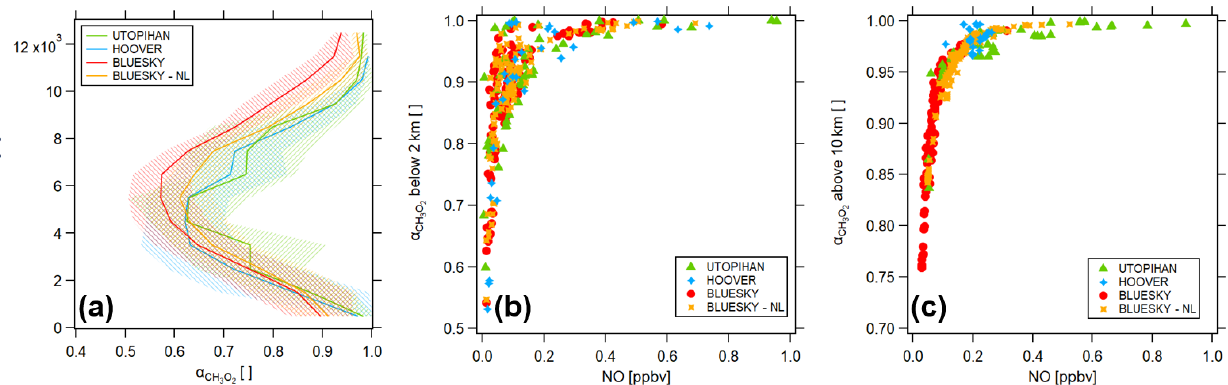
for the campaigns UTOPIHAN (green), HOOVER (blue) and BLUESKY (red) and the no-lockdown (NL) scenario Figure 7. α CH 3 O 2 (yellow) (a) as a vertical profile, (b) in correlation with NO below 2km and (c) in correlation with NO above